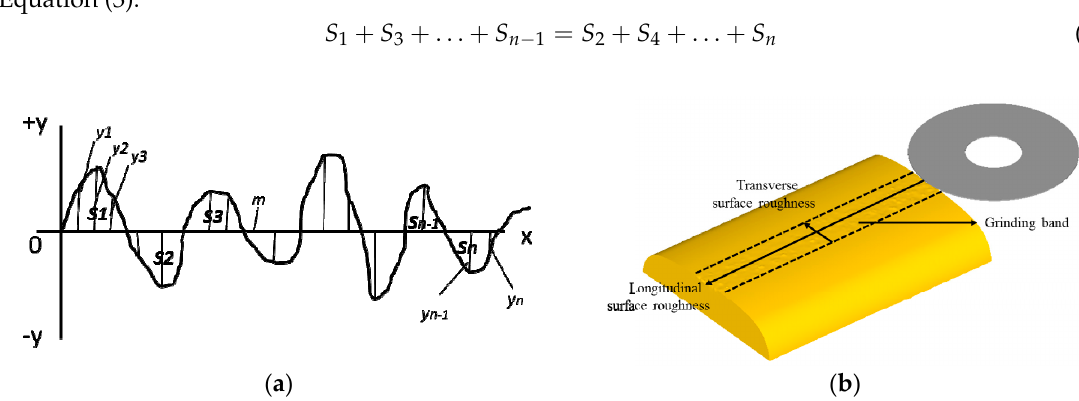
Figure 10. Schematic diagram of the surface roughness: ( a ) definition and ( b ) cross section direction.